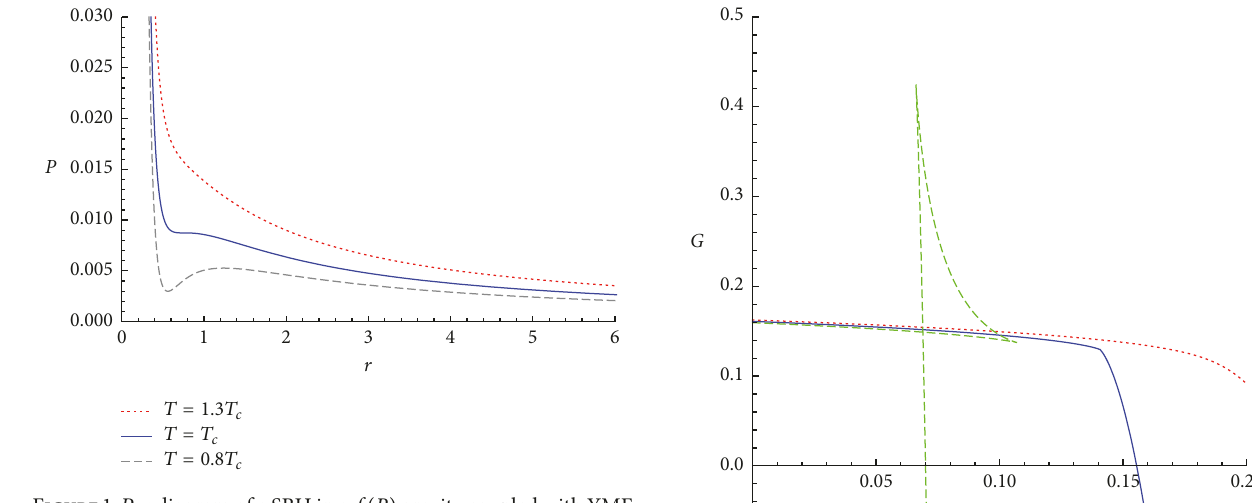
Figure 1: 𝑃 - 𝑟 diagram of a SBH in a 𝑓(𝑅) gravity coupled with YMF for 𝑄 = 0.1 and 𝜂 = 1 .